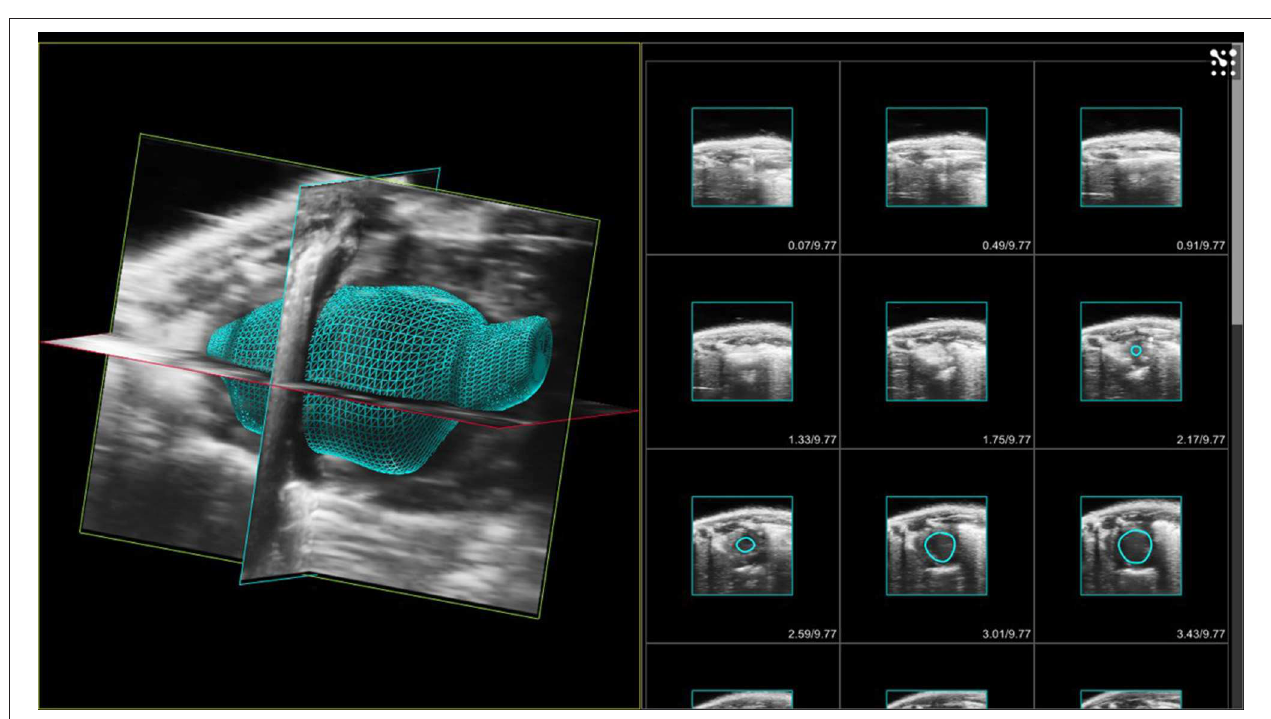
FIGURE 10 | LHS - 3D volume of murine left ventricle with aortic root. Images acquired at end-diastole. RHS 2D acquired images with endocardial borders of left ventricle highlighted in each slice.